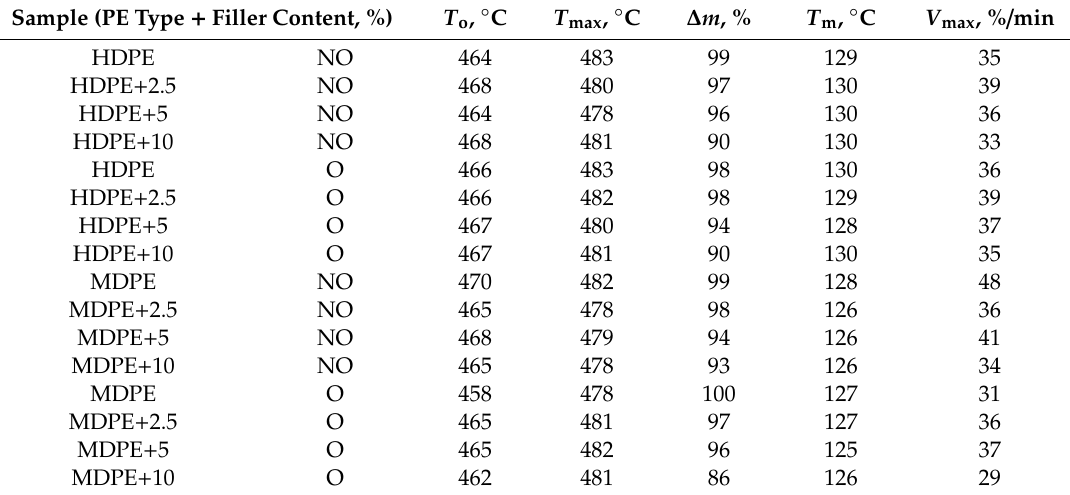
Table 3. Thermal parameters for non-oriented (NO) and oriented (O) HDPE, MDPE and their composites with Sillikolloid ( T o , temperature onset, T max , temperature at maximum process rate, ∆ m , weight loss at 600 ◦ C, T m , melting temperature, V max , maximal rate of decomposition). Sample (PE Type + Filler Content,